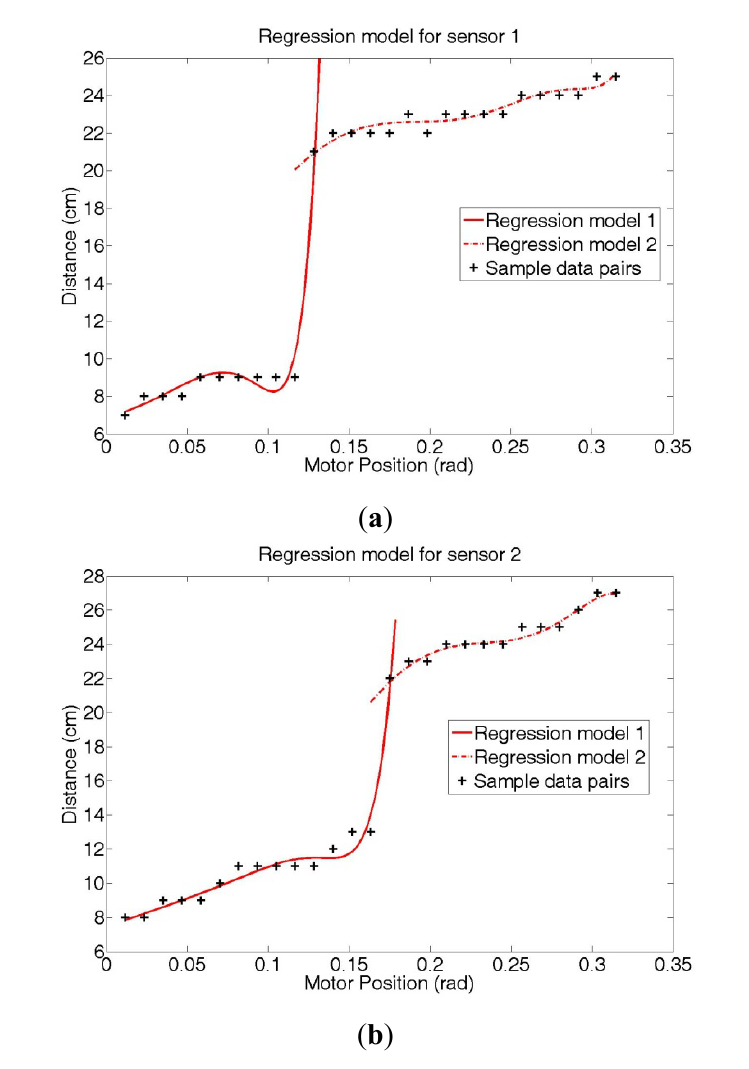
Figure 11. Function models generated by two SRI regression methods for ( a ) sensor 1 ( b ) sensor 2 ( p =